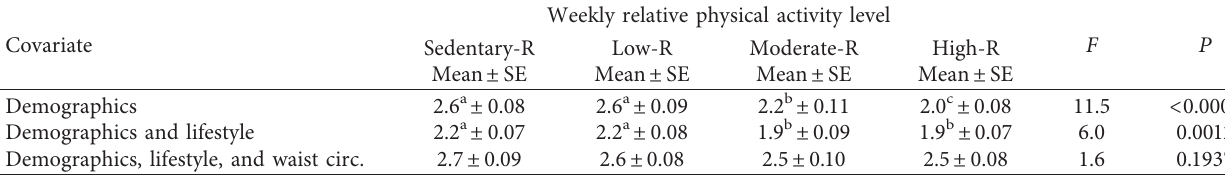
Table 2: Differences in mean HOMA values by level of weekly relative physical activity in US men and women, after adjusting for covariates.